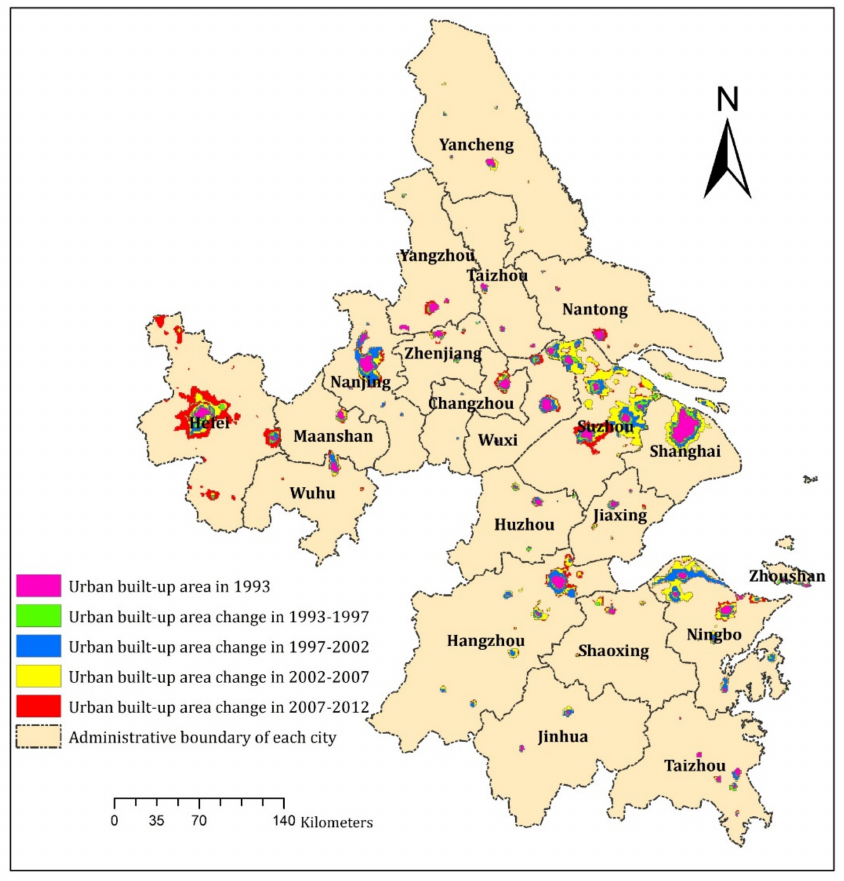
Figure 3. Changes in the urban built-up area of the YRDUA for 1993 – 2012 extracted from corrected DMSP/OLS NTL data.